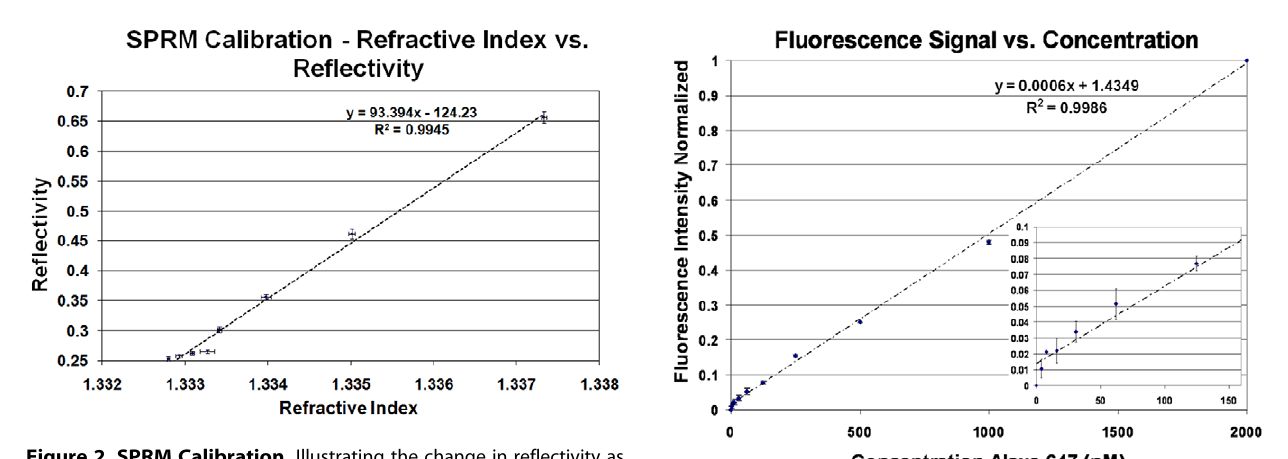
Figure 2. SPRM Calibration. Illustrating the change in reflectivity as a function of refractive index. To compensate for laser power output variations, normalization of the intensity in the region of interest in the flowcell took place against the static adhesive regions surrounding the flowcell. The different refractive indices were obtained by flowing NaCl solutions through the sample